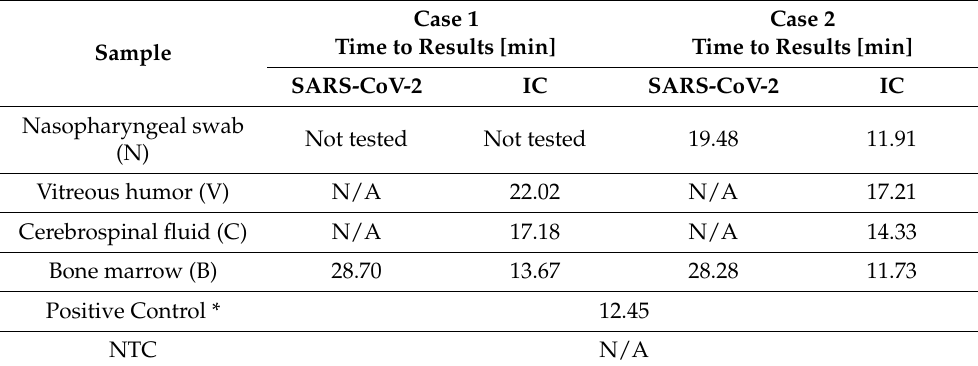
Table 1. The Real-Time LAMP results of analyzed clinical cases. The table represents the time to detection of a particular sample using Genomtec ® SARS-CoV-2 EvaGreen ® RT-LAMP CE-IVD Duo Kit (N/A–not detected).